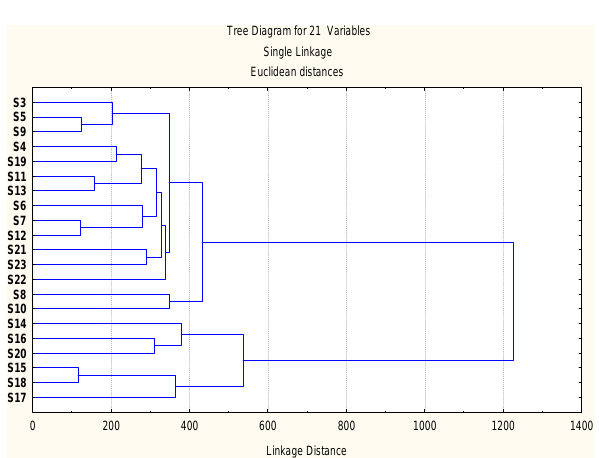
Tree Diagram for 21 Variables Single Linkage